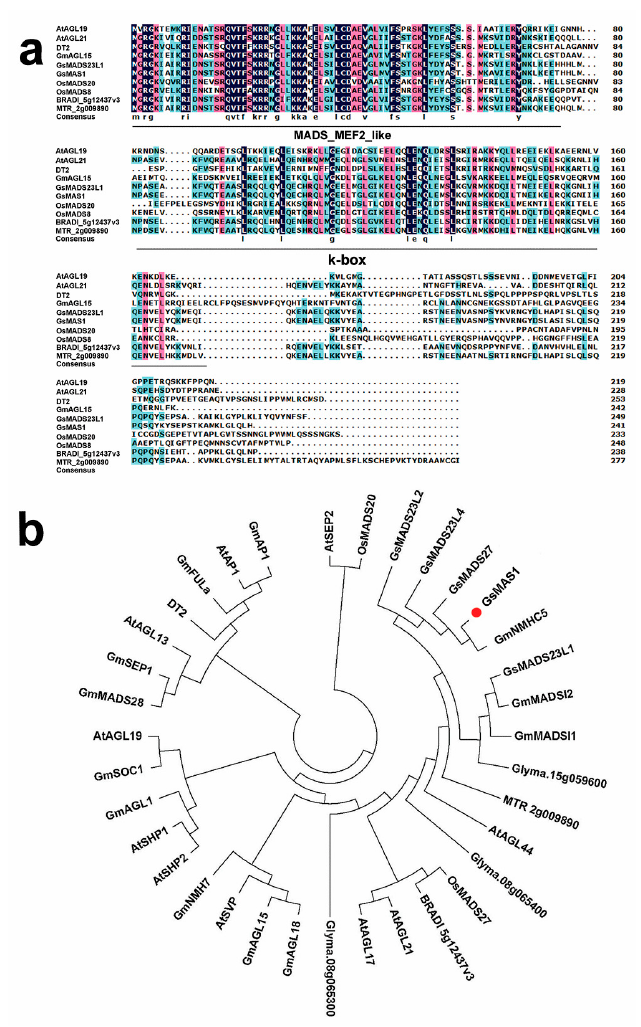
Figure 1. Homology analysis of GsMAS1 protein and other MADS-box transcription factors in plants. a. Sequence alignment of GsMAS1 protein and MADS-box transcription factors. b. Phylogenetic analysis of GsMAS1 and MADS-box transcription factors. The sequence alignment of amino acids was carried out by using the software DNAMAN6.0. The phylogenetic tree was constructed by the software MEGA (V6.0) with the neighbor-joining method. The amino acid sequences of MADS-box transcription factors are from the databases of the National Center for Biotechnology Information (NCBI) (https://www.ncbi.nlm.nih.gov/) and Phytozome (http://phytozome.net/). The information of accession number and species for MADS-box transcription factors is as follows. The proteins of